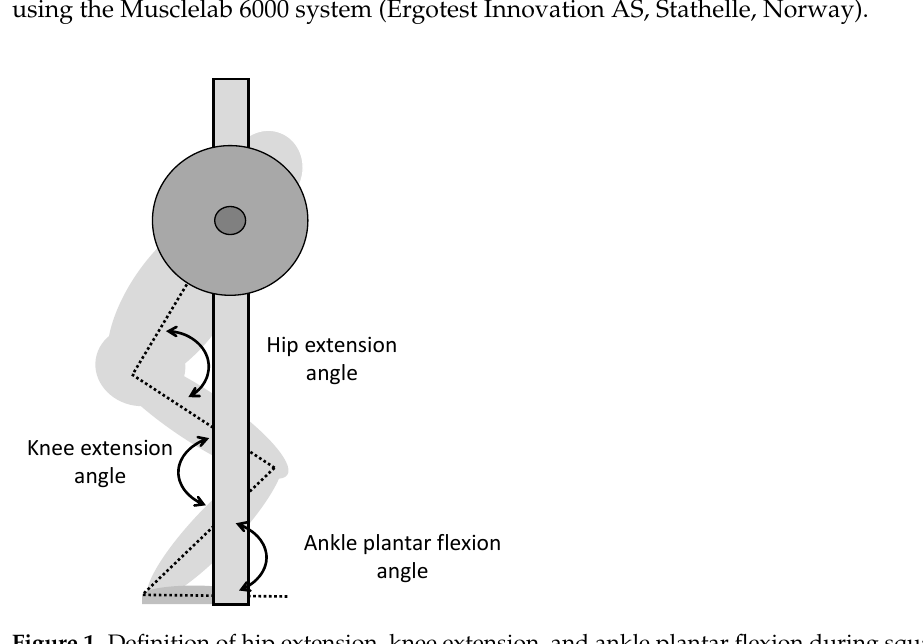
Figure 1. Definition of hip extension, knee extension, and ankle plantar flexion during squats in a Smith machine.